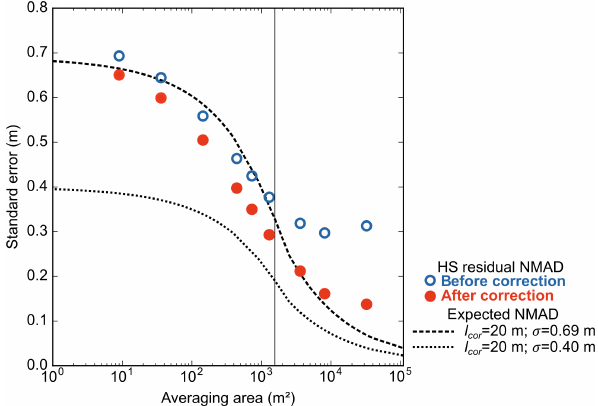
Figure 10. Measured error and modeled error (Rolstad et al., 2009) of the HS averaged over different areas. Modeled error (dashed line) is predicted based on different random error per pixel ( σ ) and au- tocorrelation length ( l cor ; Eq. 3). The lines are the modeled error based on l cor from the semivariogram and σ taken as the NMAD derived from stable-terrain residuals (dotted line) and HS residuals (dashed line). Empty blue circles are the NMAD of the residual HS maps averaged at different resolutions before the undulation cor- rection. Filled red circles are the NMAD of the residual HS maps averaged at different resolutions after the undulation